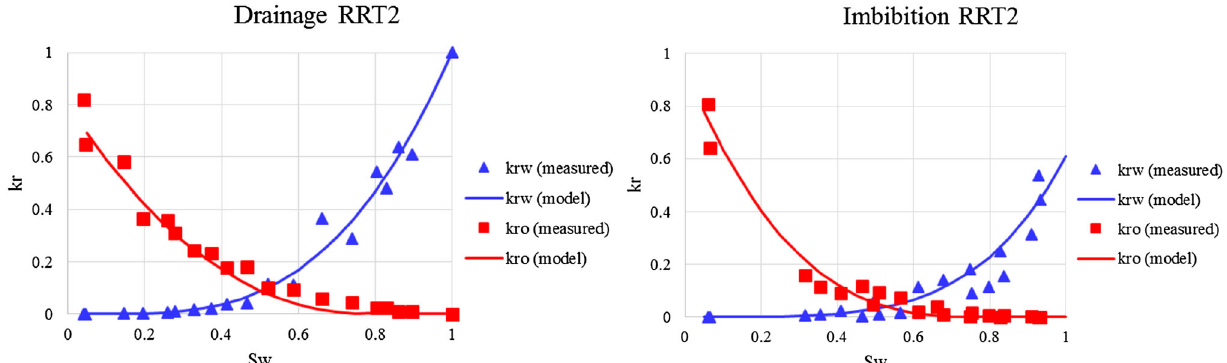
Fig. 21 Drainage and imbibition K r correlation for RRT